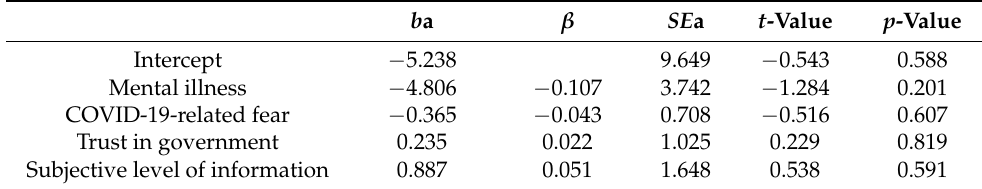
Table 6. Regression coefficients predicting a deterioration in health status